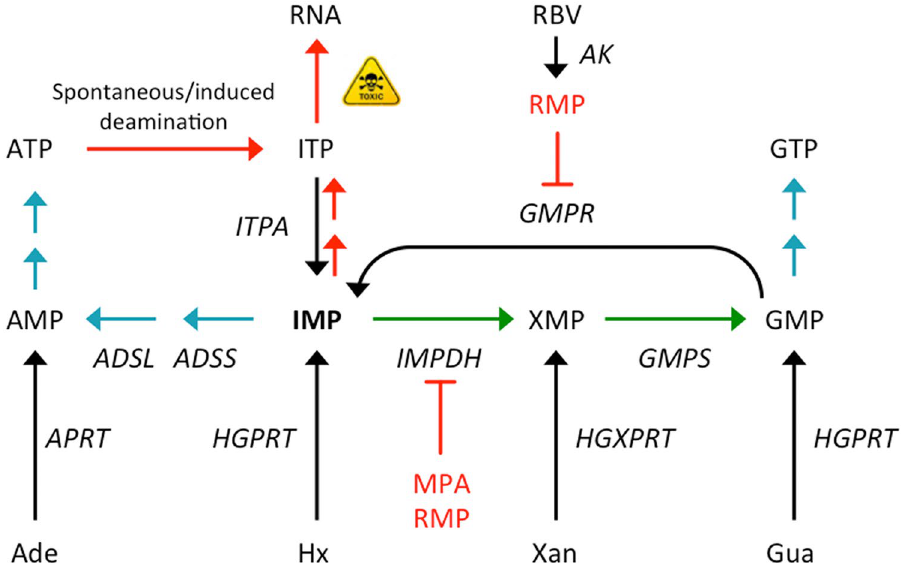
Figure 6. Role of ITPA in purine metabolism in T. brucei . Simplified schematic representation of the purine salvage and interconversion enzymes identified in T. brucei . ITP can arise from ATP by spontaneous or induced deamination or from consecutive phosphorylation of IMP. Enzymatic activities are depicted as follows: ITPA, inosine triphosphate pyrophosphatase; APRT, adenine phosphoribosyltransferase; IMPDH, inosine monophosphate dehydrogenase; GMPS, guanine monophosphate synthase; GMPR, guanosine monophosphate reductase; ADSS, adenylosuccinate synthetase; ADSL, adenylosuccinate lyase; HGPRT, hypoxanthine–guanine phosphoribosyltransferase; HGXPRT, hypoxanthine–guanine–xanthine phosphoribosyltransferase; AK, adenosine kinase; Ade, adenine; Hx, hypoxanthine; Xan, xanthine; Gua, guanine; RBV, ribavirin.